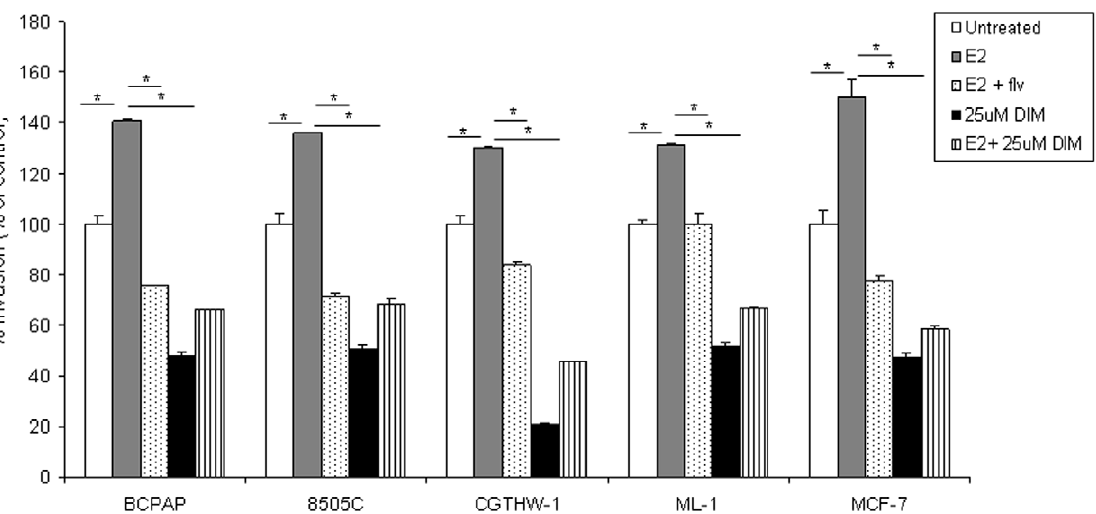
Figure 4. DIM reduces invasion of thyroid cells. 2.5 6 10 4 cells resuspended in 500 m l medium containing 1% FBS 6 10 2 8 M E 2 6 10 2 6 M fulvestrant 6 25 m M DIM were seeded in the upper chamber of growth factor reduced matrigel invasion chambers. 750 m l of growth medium containing 5% FBS was used as chemoattractant in the bottom chamber. Percent invasion was calculated based on the number of cells invading through the chambers relative to the cells migrating through control membrane after 18 hours. The groups are as follows- untreated (white bars), E 2 treated (grey bars), E 2 and ICI (dotted bars), 25 m M DIM (black bars) and E 2 & 25 m M DIM treated (striped bars). Data is represented as % invasion which is mean number of invaded cells per 10X field micrograph for each sample well relative to the migration through the control membrane and normalized to the untreated control. The asterisk denotes statistically significant differences ( p , 0.05) between the indicated samples.